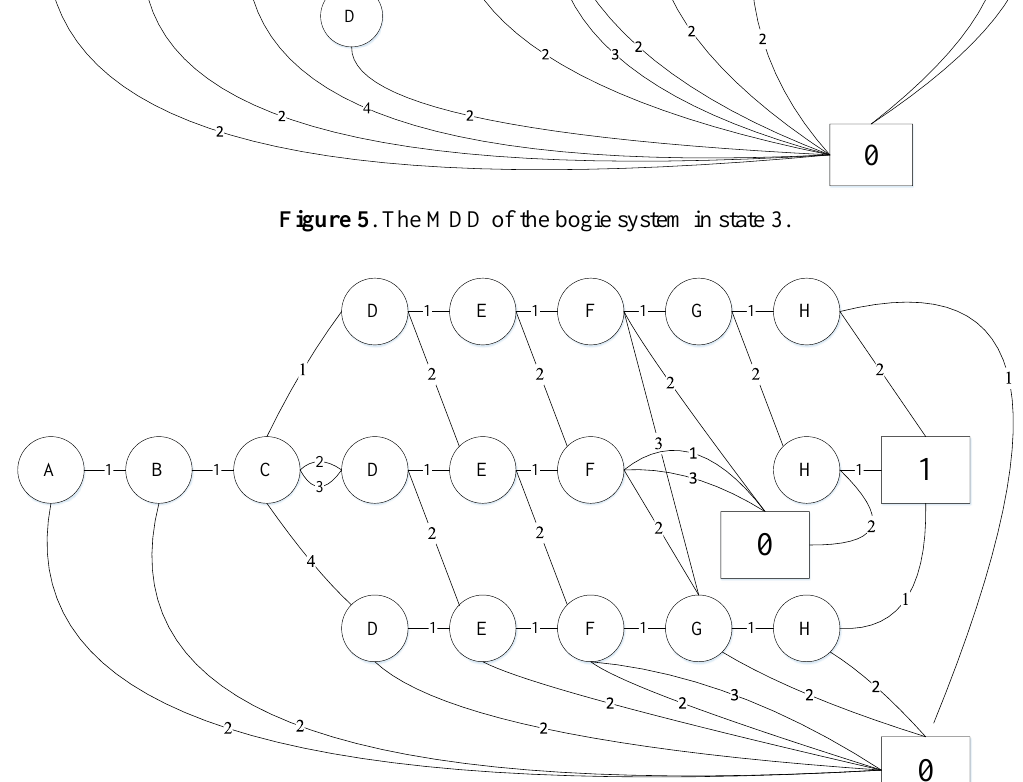
Figure 6 . The MDD of the bogie system in state